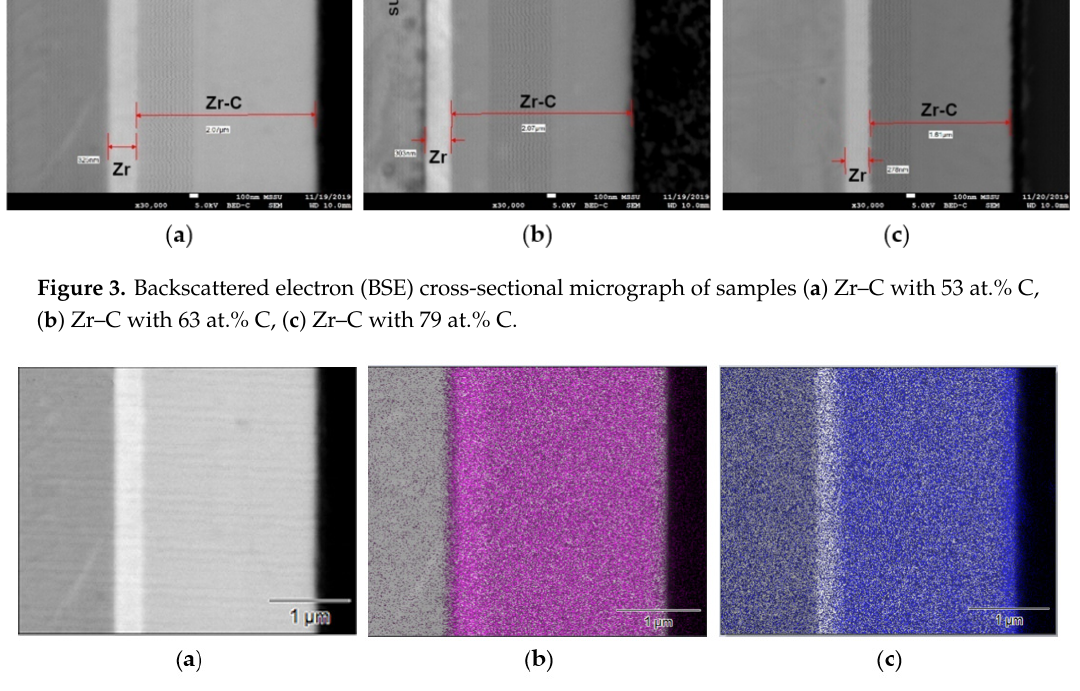
Figure 4. ( a ) Cross-sectional micrograph for sample with 53 at.% C, with ( b ) an example of mapping distribution of C and ( c ) an example of mapping distribution of Zr.